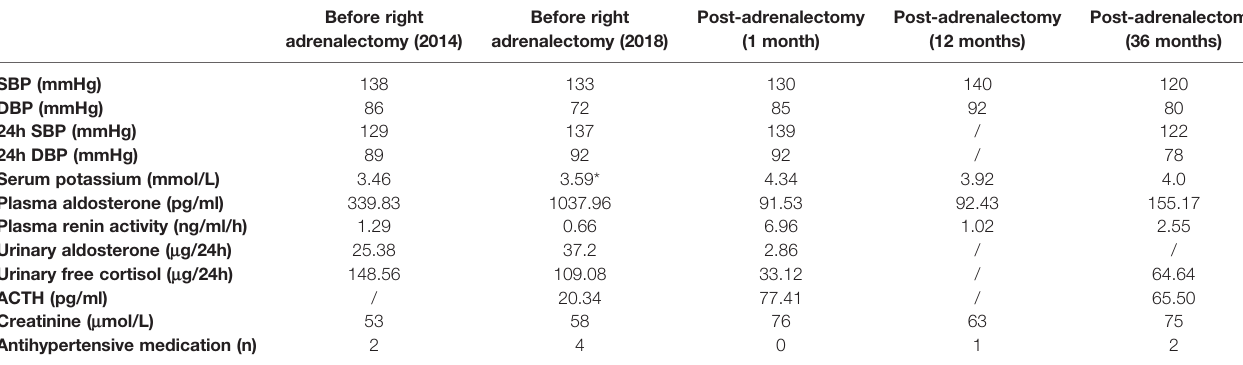
TABLE 2 | Baseline and post-right-adrenalectomy clinical characteristics.